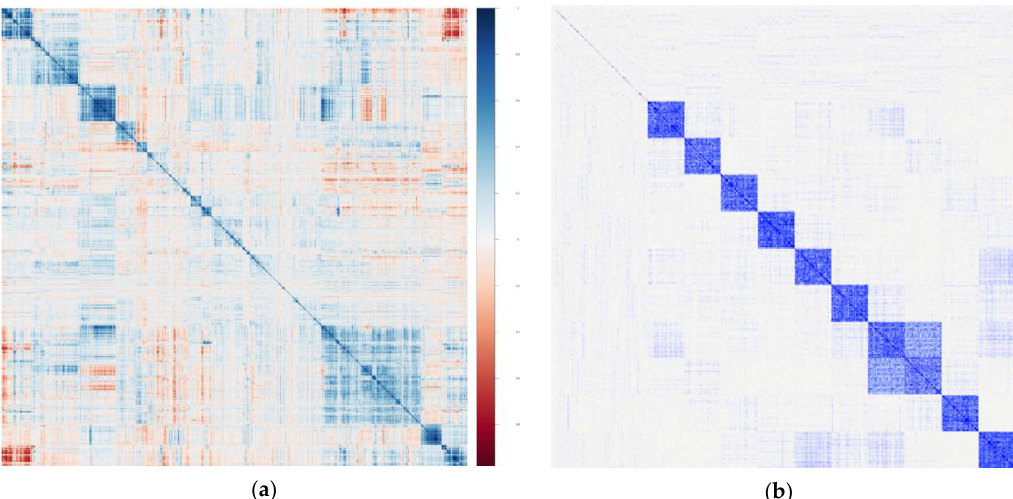
Figure 2. Actual and simulated metabolomics data. Previously analyzed data, or prior detailed knowledge of the structure of metabolomics data collected from an existing large epidemiologic cohort study ( a ) can be used to construct simulated data that mimics the data structure observed from real measures ( b ). These simulated data can be used to estimate statistical power, based on one or more methods of analyses, for planning the design of a future